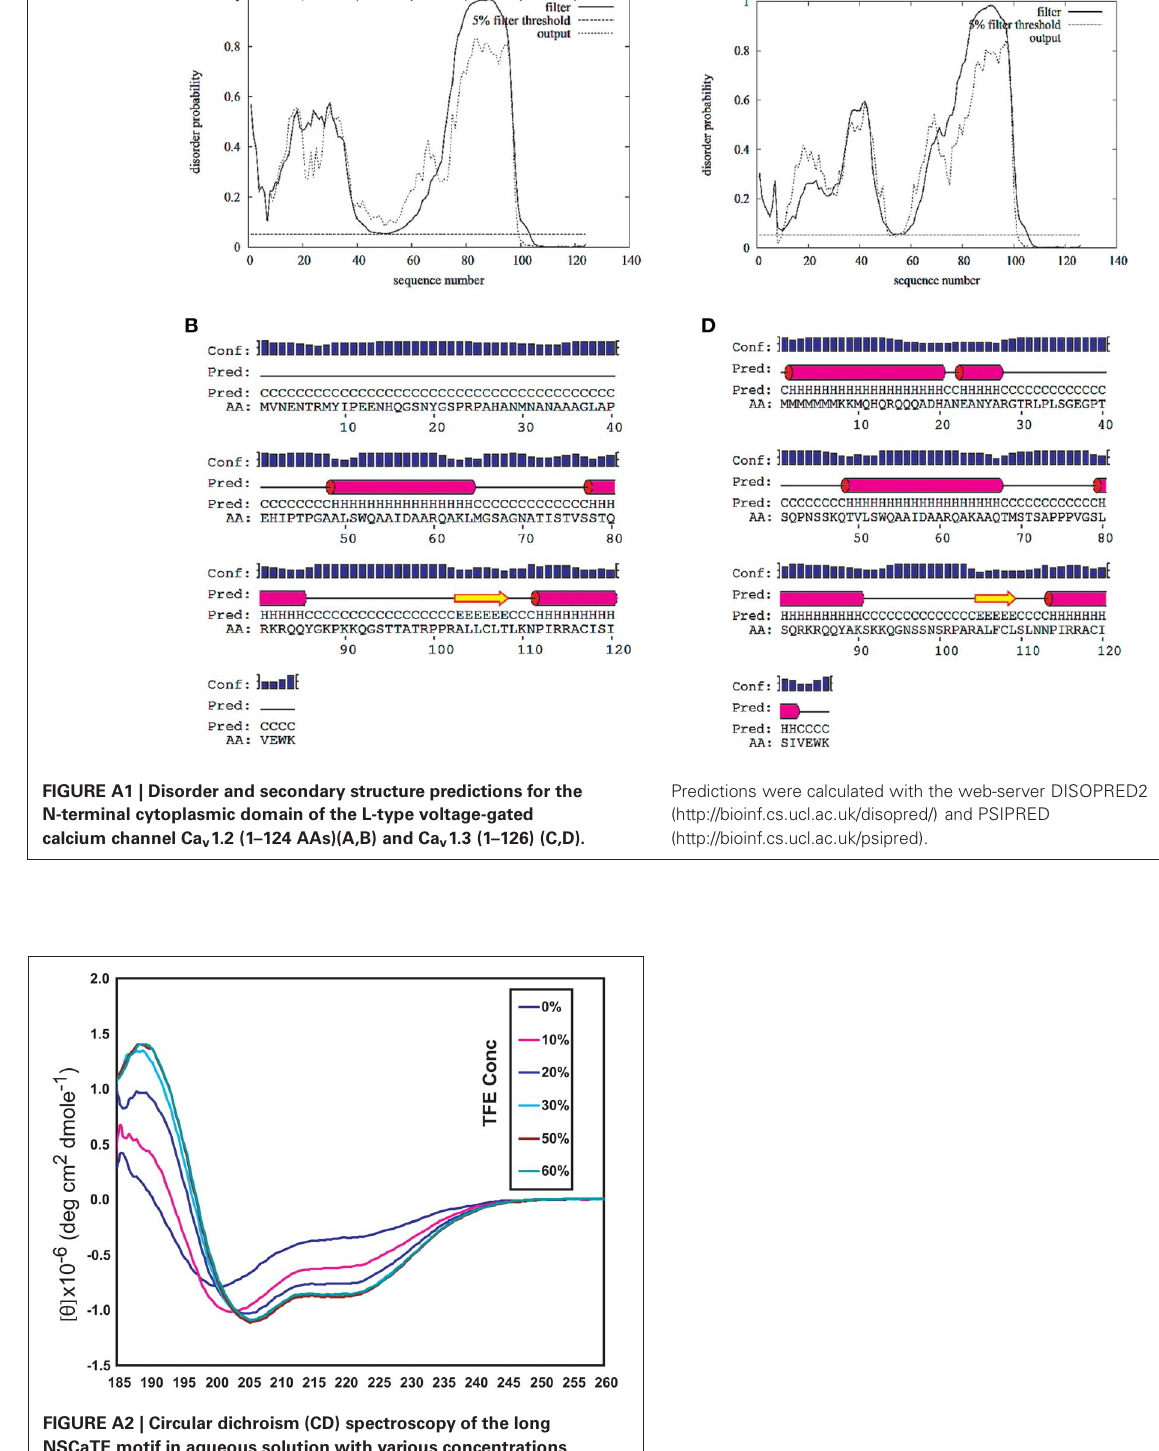
FIGURE A2 | Circular dichroism (CD) spectroscopy of the long NSCaTE motif in aqueous solution with various concentrations of TFE